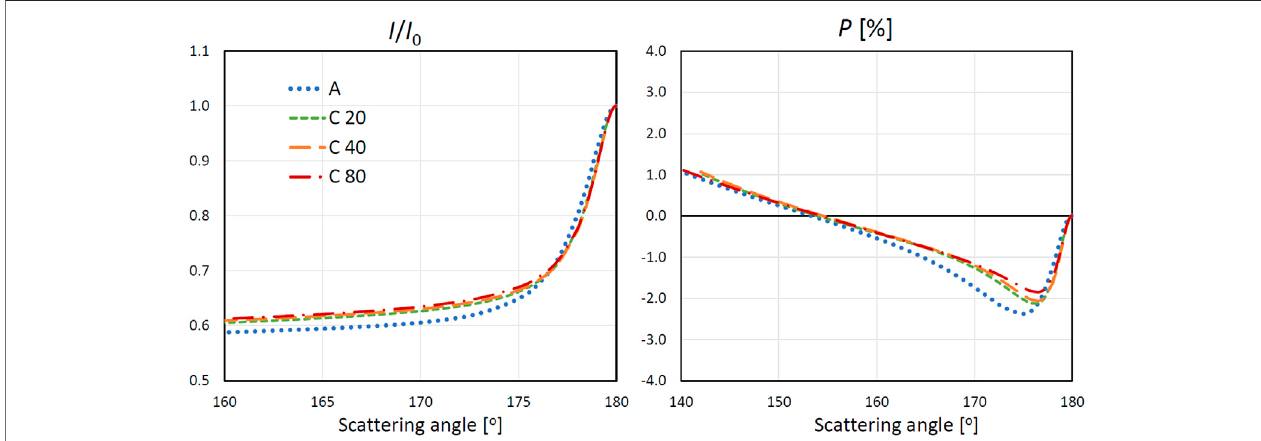
FIGURE 2 | The intensity normalized to a value at ϑ = 180 ° I / I 0 and the degree of linear polarization P of light re fl ected by a semi-in fi nite medium composed of clustersindependenceonthescatteringangle.Thecurvesfordifferentnumbersofparticlesintheclusters(modelC)arecomparedtoeachotherandthoseforindividual particles in a medium (model A) with ξ = 20%. The values of x , m , and Im ( m eff ) are speci fi ed in the text.